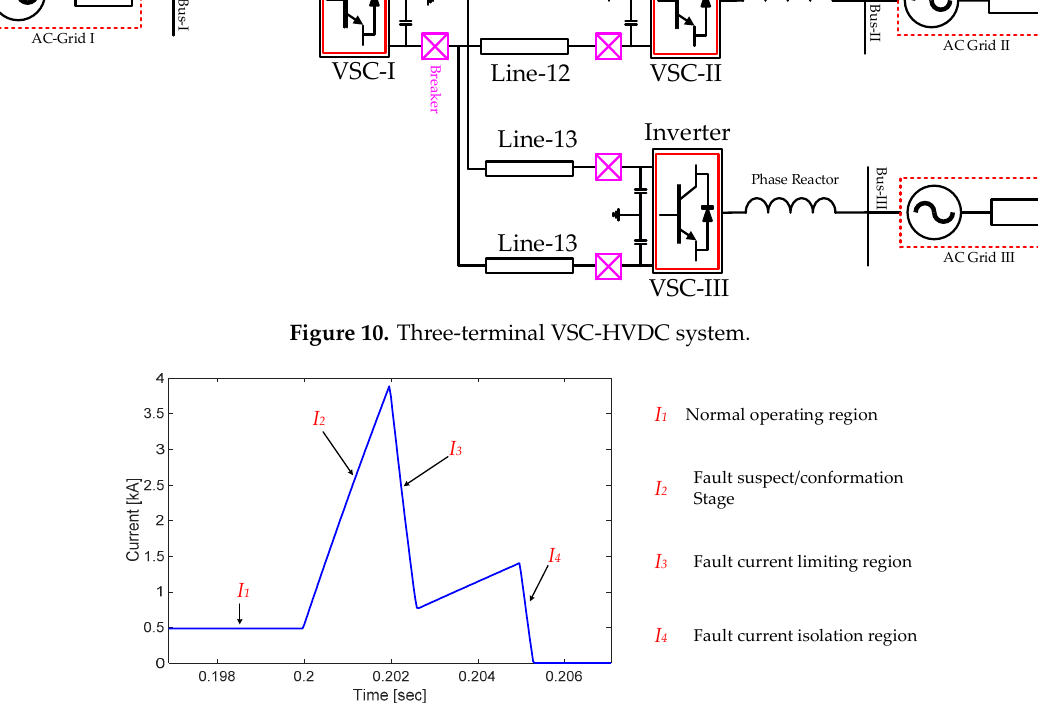
( c ) Figure 12. Current through different branches of breaker: ( a ) main branch; ( b ) FCLC (auxiliary branch); ( c ) MOA m. 0.2 0.201 0.202 0.203 Time [sec] 01234